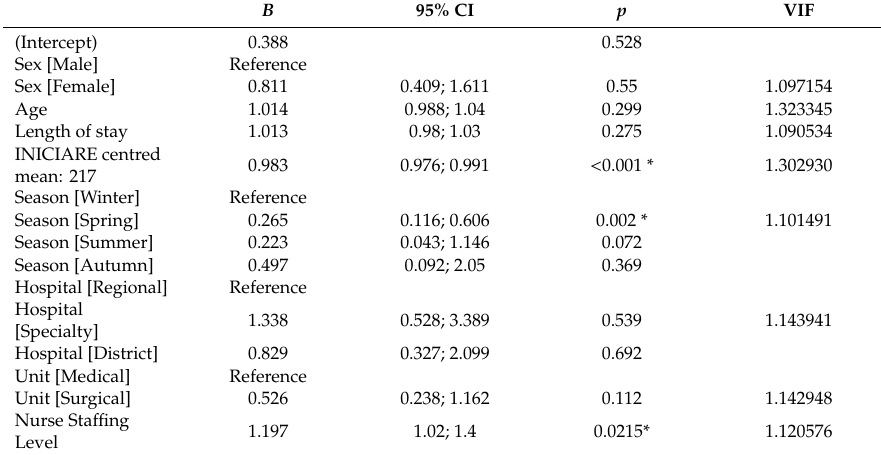
Table 2. Multivariate logistic regression